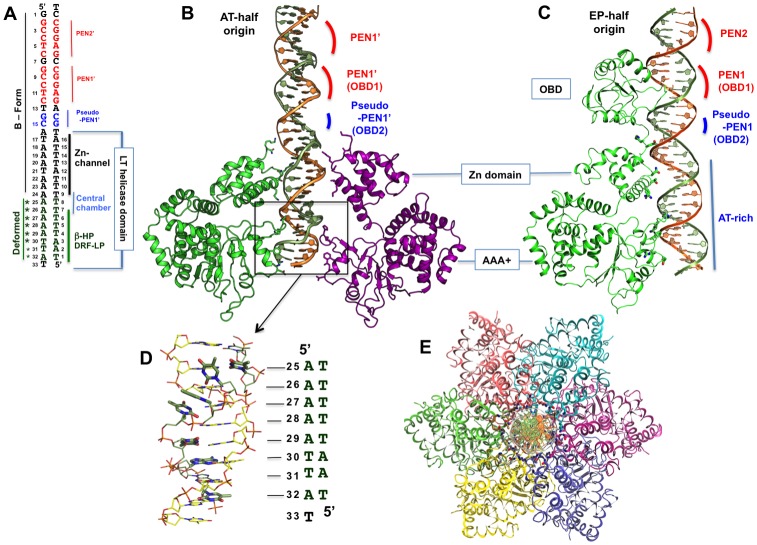
The structure of the LT hexamer helicase in complex with the AT-half origin.(A) The AT-half origin DNA sequence contains 32 bp with 3’-T overhangs bound by LT hexameric helicase in (B). The side-bars indicate the DNA contacts by different regions within the LT helicase channel, including the Zn-domain, the central chamber, the β-hairpins (β-HP) and DRF loops (DRF-LP). PEN1’ and pseudo-PEN1’ are not occupied by OBD in LT hexamer structure. The deformed region is indicated on the side. (B) The structure of LT131 hexamer bound to the 32-bp AT-half origin DNA. For clarity, only two subunits (one on each side) are shown. The positions of the PEN1’ and pseudo-PEN1’ where OBD1 and OBD2 would bind are indicated. (C) The structure of LT131 dimer bound to the 32-bp EP-half origin DNA (PDBid: 4GDF), showing one of the two subunits using its OBD to bind PEN1. The pseudo-PEN1’ is bound by the OBD of the second subunit of the dimer (Figure 1—figure supplement 1A,B); thehelicase domain of the dimer, including the Zn-domain and the AAA+ domain, binds to the AT-rich region of the EP-half origin. The structures in (B) and (C) are drawn to scale and aligned side-by-side for comparison between the hexamer-DNA and dimer-DNA complexes. (D) The dsDNA segment bound in the AAA+ channel is deformed and locally melted. (E) Top view of the LT hexamer (each subunit in a discrete color) from the N-terminal end, showing dsDNA in the central channel.